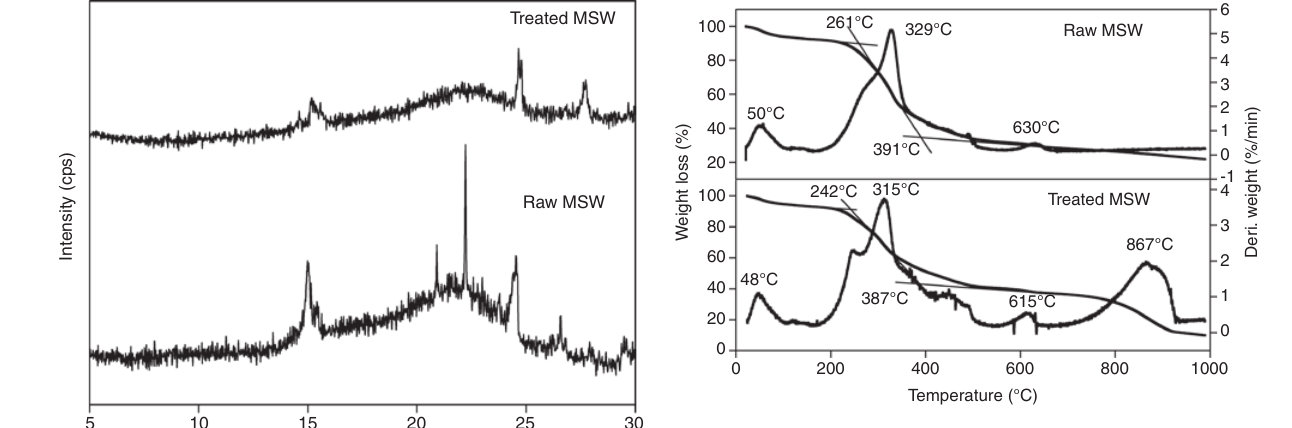
Figure 6 TG/DTG of raw and treated MSW.